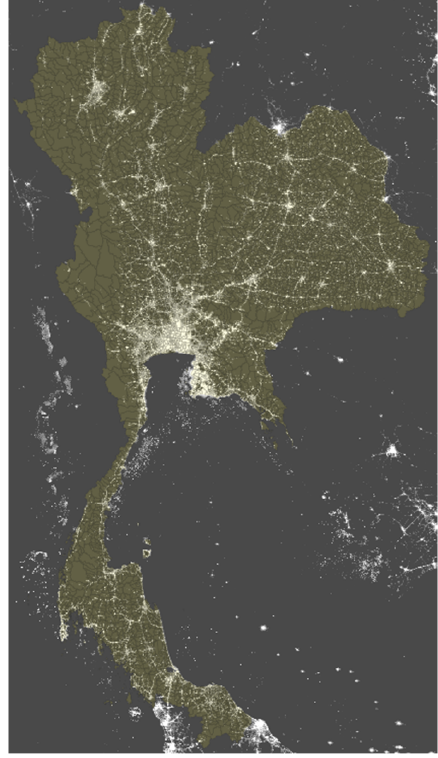
Figure 3. Spatial distribution of NTL in 2017. Source: Google Earth Engine.